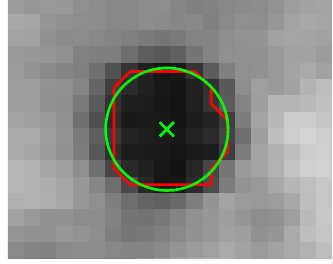
Figure 7: Automatic measurement of a GCP in a thermal